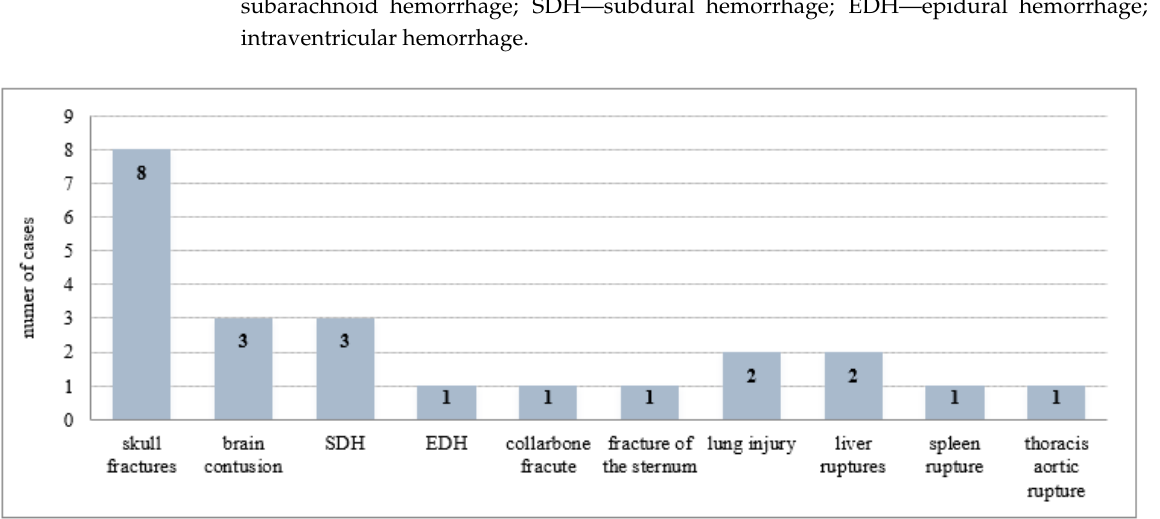
Figure 6. Total number of false positive CT scans in comparison with the autopsy. SDH—subdural hemorrhage; EDH—epidural hemorrhage.